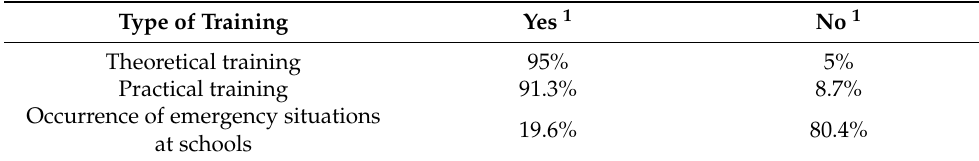
Table 6. Training formally used at schools.